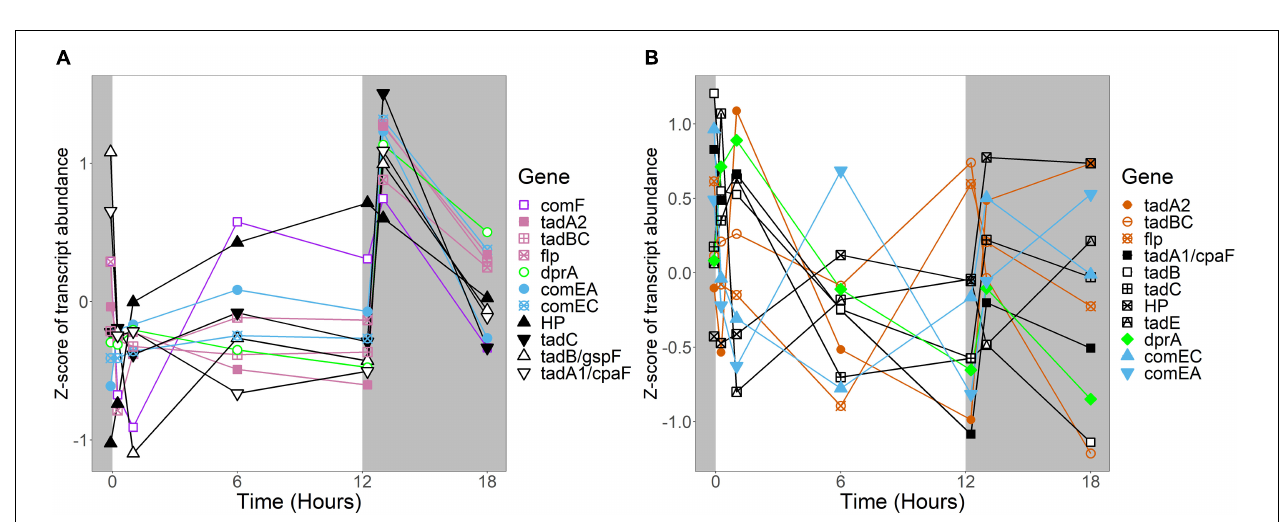
FIGURE 7 | Expression of putative ATP synthase genes. Expression is plotted as z-score of each transcript. (A) Putative ATP synthase genes in R. lacicola . (B) Putative ATP synthase genes in A. photophilum strain MWH-Mo1.